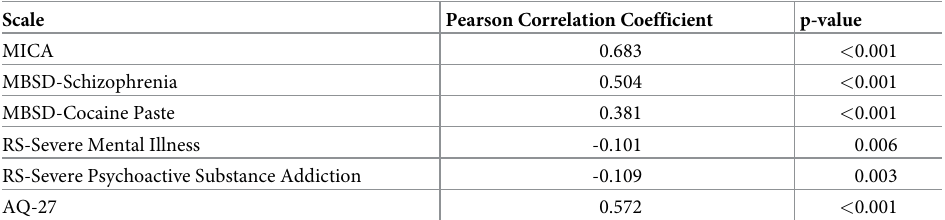
Table 3. Pearson correlations between Opening Minds Scale for Health Care Providers (OMS-HC) and other scale scores.